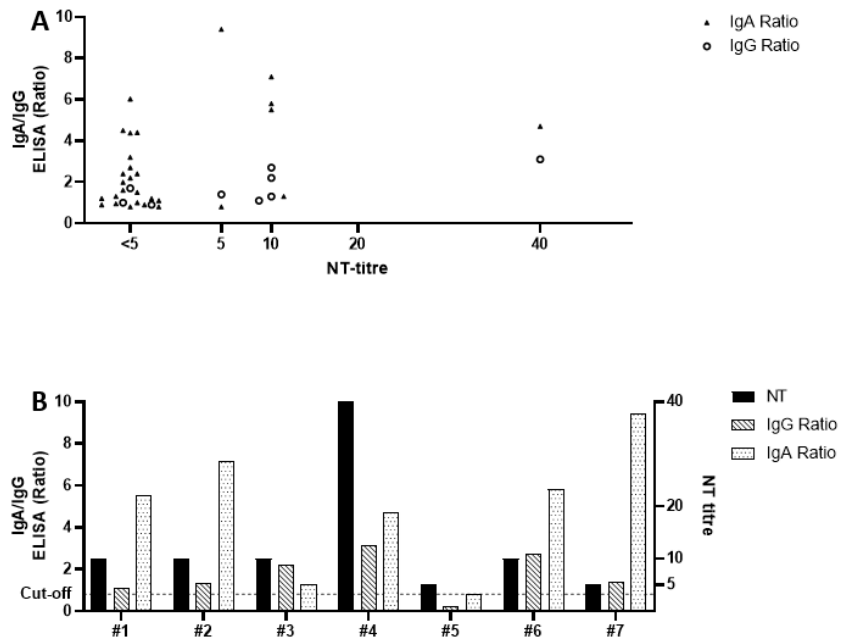
Figure 2. Comparison of ELISA ratios and neutralization assay (NT) titers. ( A ). A total of 32 samples were reactive in either one or both ELISA. The majority (23/29) of IgA-reactive samples showed no neutralizing effect, whereas two-thirds (6/9) of IgG-reactive samples were also positive for SARS-CoV-2-neutralizing antibodies. ( B ). Of the seven samples (#1–7) with detectable levels of neutralizing antibodies, all were reactive for IgA, and all but one (#5) were reactive for IgG. Overall, when comparing ELISA results and NT titers, no prediction could be made about the levels of neutralizing antibodies from the ELISA ratios (neither IgA nor